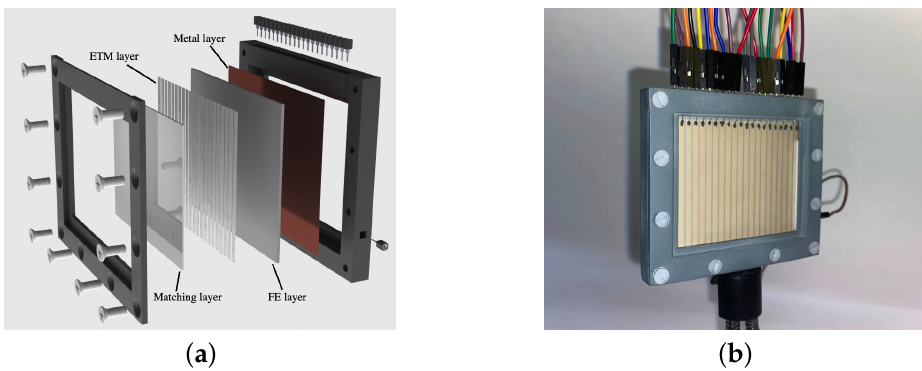
Figure 10. Exploded-view drawing ( a ) and photo (matching layer removed) ( b ) of the FE reflector prototype